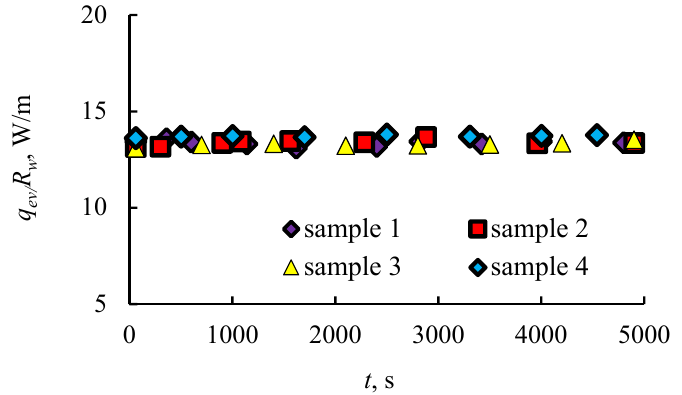
◦ C, samples correspond to Table Figure 9. q ev / R w with time ( T w = 41 °C, samples correspond to Table 1). Figure 9. q ev / R w with time ( T w = 41 °C, samples correspond to Table 1). Figure 9. q ev / R w with time ( T w = 41